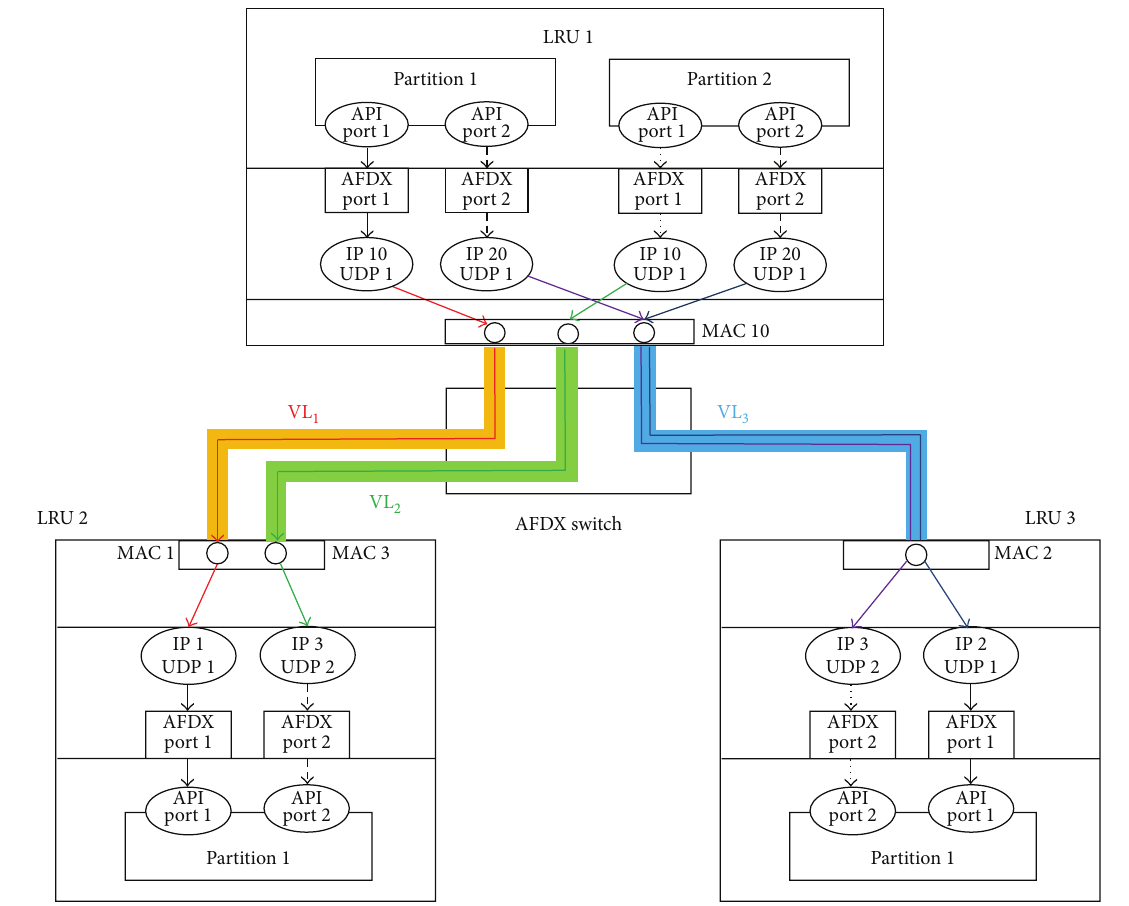
Figure 1: An example of virtual links in an AFDX switch.